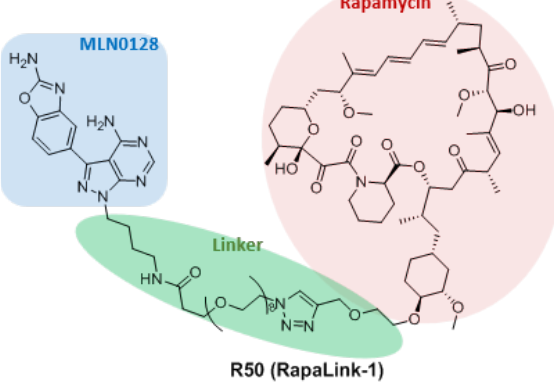
Figure 8. Structures of dual binding site inhibitor RapaLink-1 .